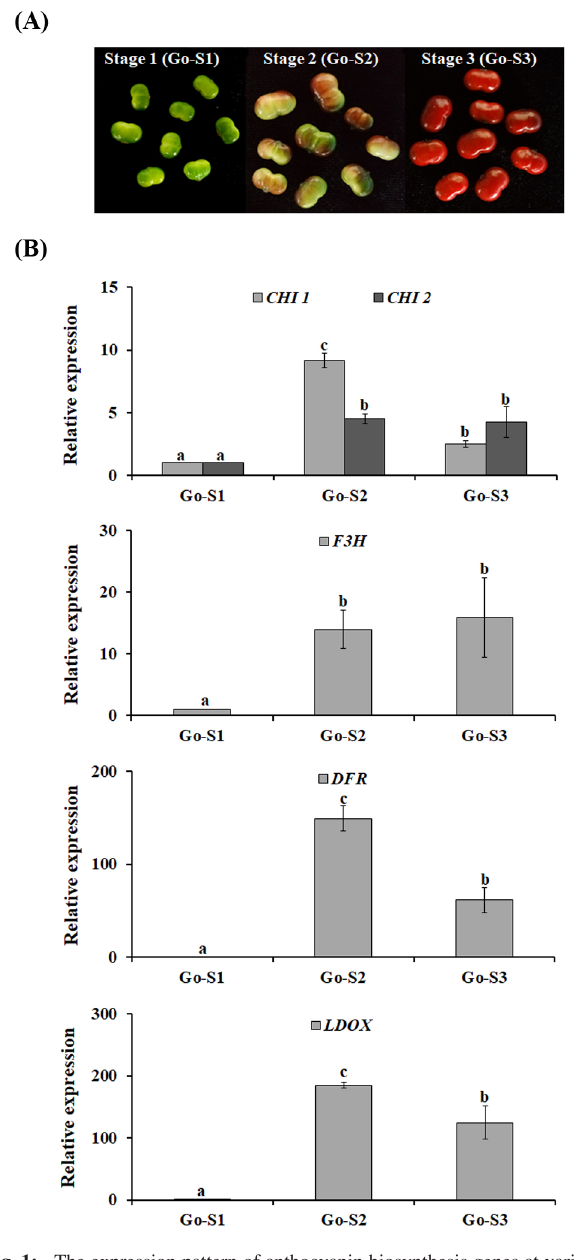
Fig. 1: The expression pattern of anthocyanin biosynthesis genes at various stages of the ripening process. (A) Panax ginseng berry ripening stages considered in this study. (B) The expression levels for each gene were calculated relative to their expression in stage 1. Enzyme names were abbreviated as follows: chalcone synthase (CHS), flavanone 3-hydroxylase (F3H), dihydroflavonol 4-reductase (DFR) and leucoanthocyanidin dioxygenase